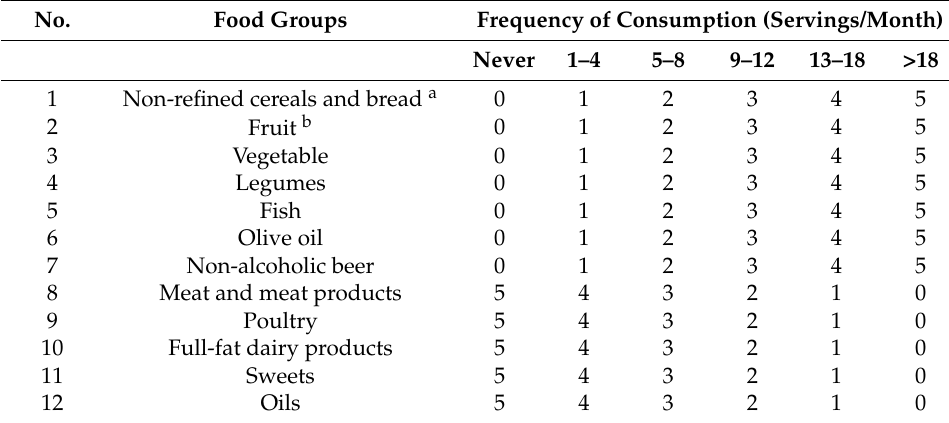
Table 1. The Saudi dietary guideline